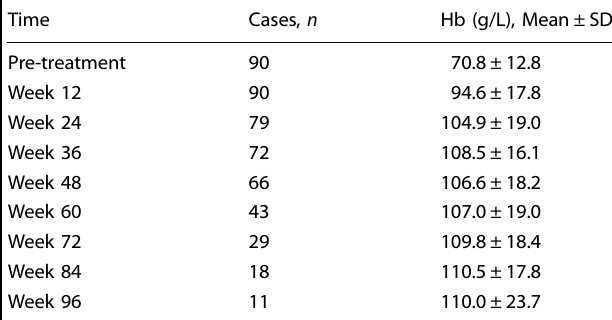
Signal Transduction and Targeted Therapy (2021)